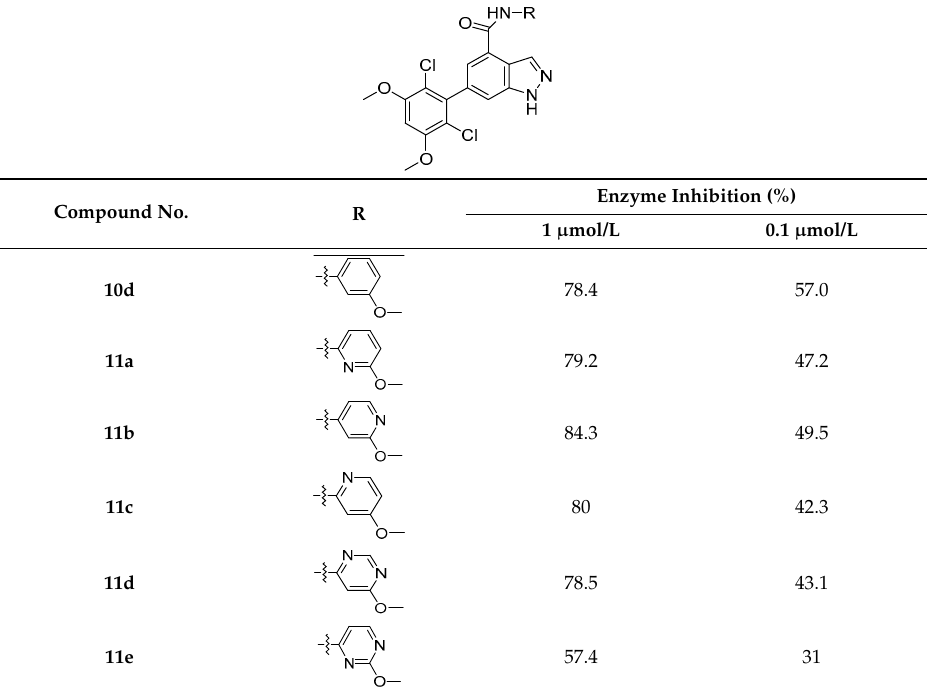
Table 3. Structures and activities of indazole derivatives 12a – i .